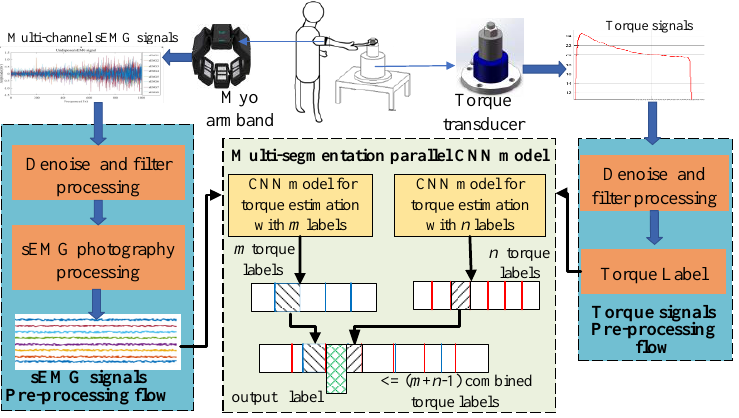
Figure 1. Research framework and the architecture of the multi-segmentation parallel convolution neural network (MSP-CNN) model.